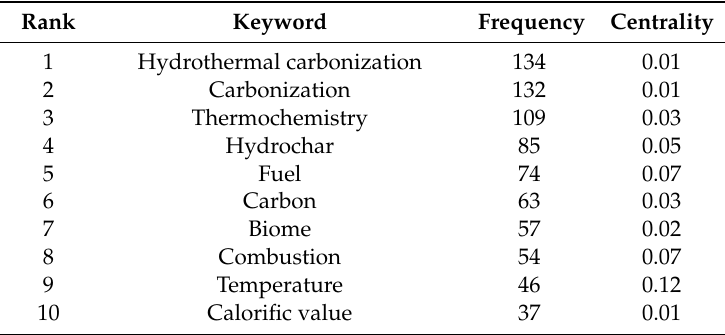
Table 2. The top 10 keywords related to ‘hydrochar as fuel’ research field for the years 2018–2020. Rank Keyword Frequency Centrality 1 Hydrothermal carbonization 134 0.01 2 Carbonization 132 0.01 3 Thermochemistry 109 0.03 4 Hydrochar 85 0.05 5 Fuel 74 0.07 6 Carbon 63 0.03 7 Biome 57 0.02 8 Combustion 54 0.07 9 Temperature 46 0.12 10 Calorific value 37